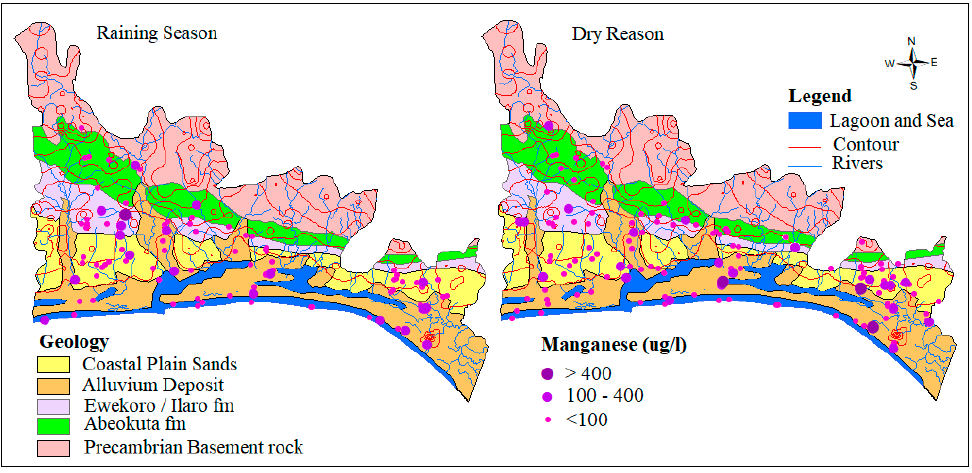
Figure 8. Spatial distribution of Mn 2+ in µg/L.